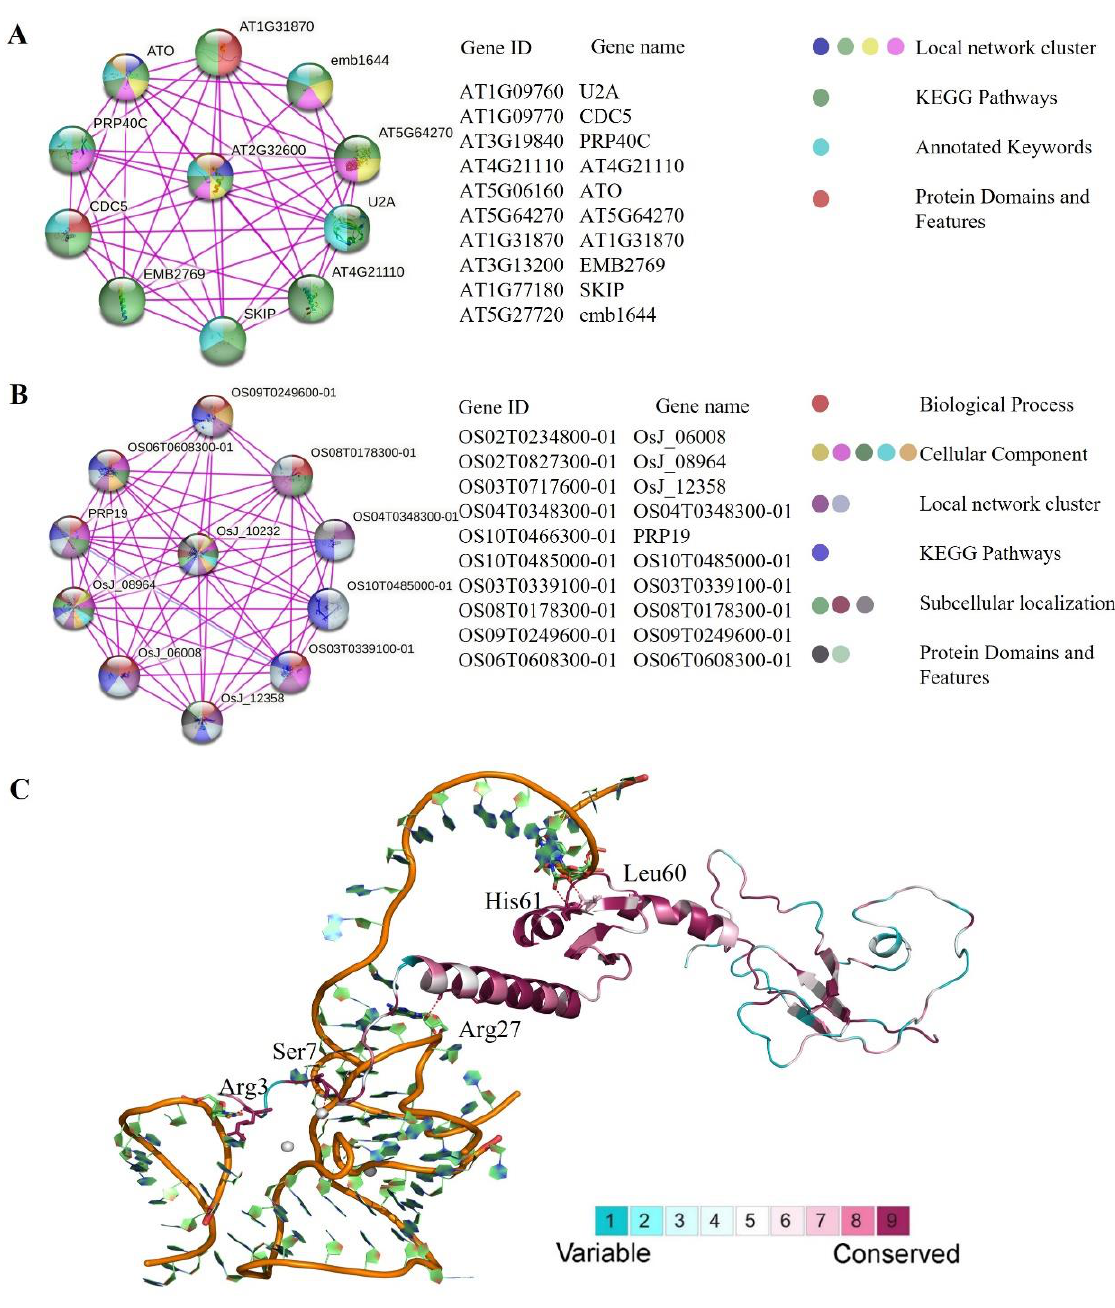
Figure 7. Protein – protein interactions (PPI) with SF3a2. ( A ) Proteins interacting with ATSF3a2. ( B ) Proteins interacting with OsSF3a2. Different spheres represent different genes. The different colors in the sphere indicate the basis of their interaction, listed on the right. The gene ID and gene name are listed in the middle. ( C ) Ribbon representations of plant SF3a2s. The 3D structure representation of plant SF3a2s is colored according to the degree of conservation among the selected 83 SF3a2s sequences based on the homology structure of Arabidopsis. The color bar from blue to red indicates the increase in conservation. The key residues are labeled according to the ATSF3a2s sequence AT2G32600.